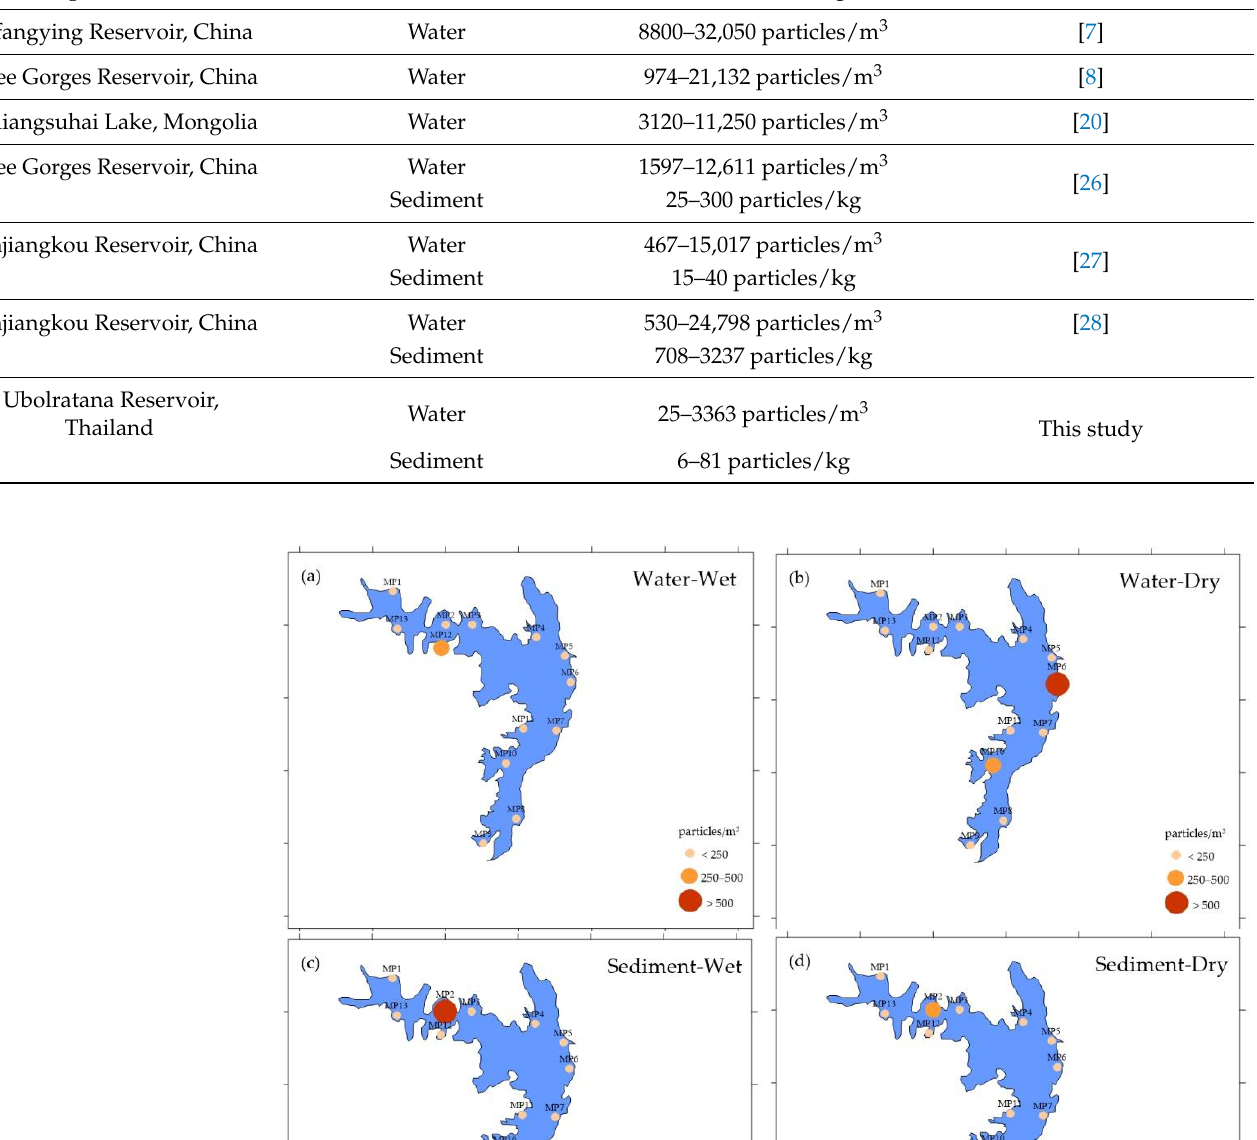
Table 1. Previous studies detailing microplastic abundance in reservoirs.